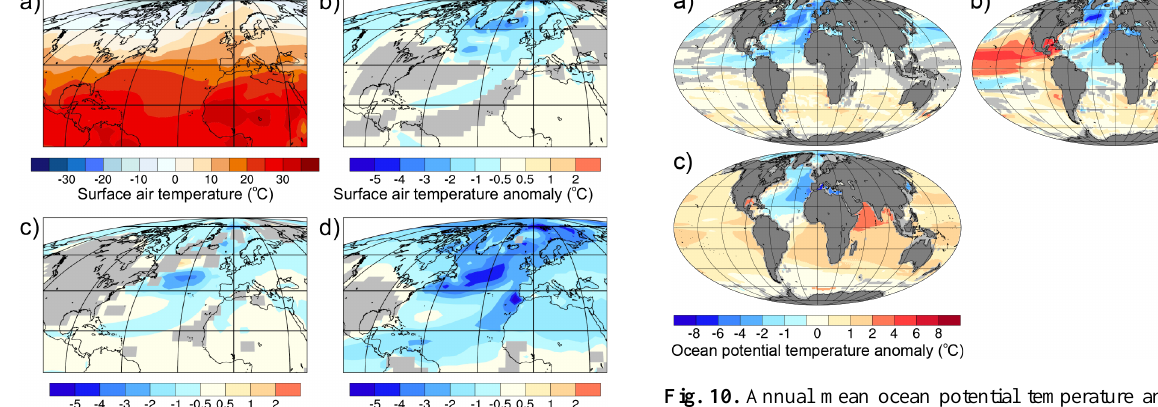
Fig. 10. Annual mean ocean potential temperature anomalies (in ◦ C) for fresh-normal with respect to Messinian control at a depth of (a) 5m (b) 204m and (c) 996m. Continental land masses are masked in dark grey. Anomalies with < 95% confidence in signifi- cance using a student t test are masked in light